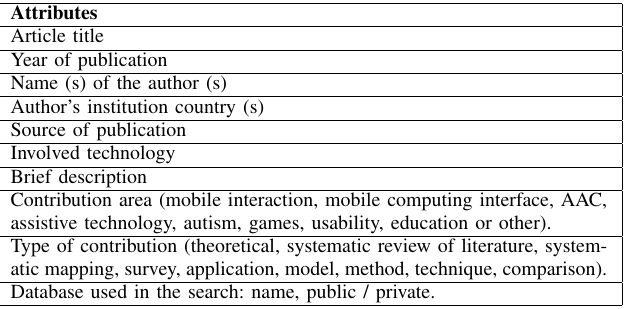
2nd Filter - Selection Criteria MOB : Application running on mobile devices or related theme.